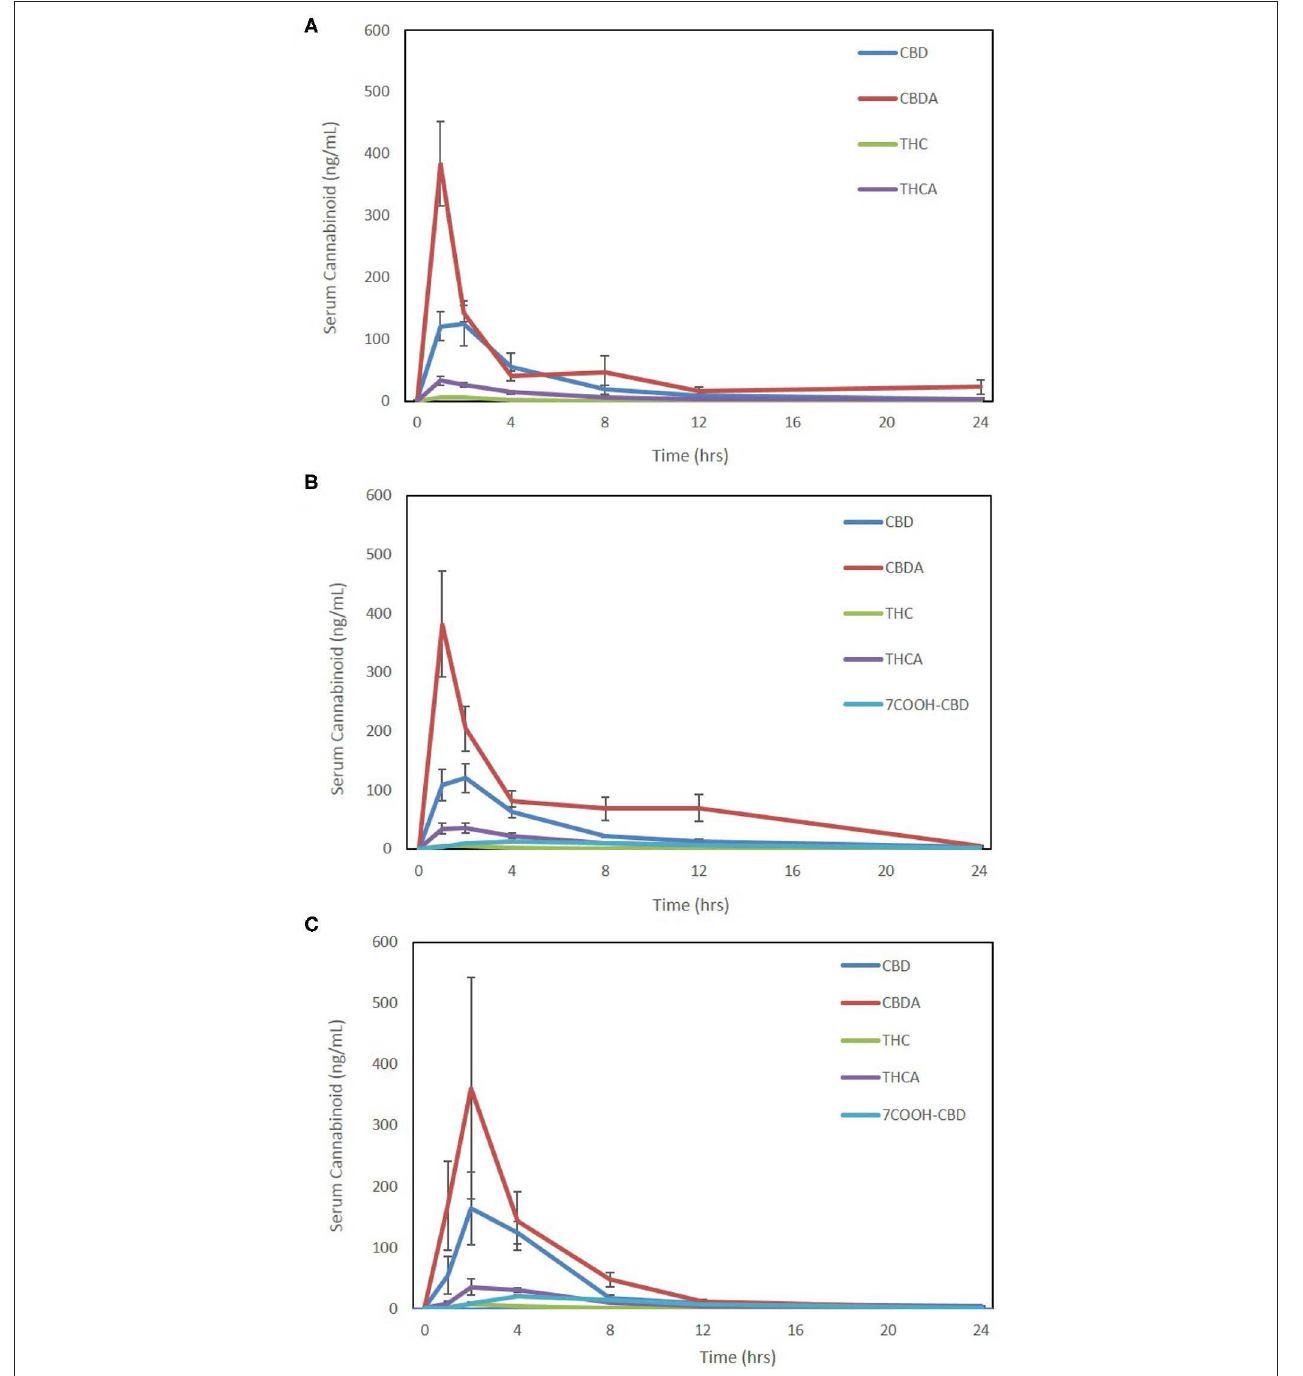
FIGURE 2 | Seven-point 24-h pharmacokinetics of three oral hemp-based forms showing oral absorption kinetics (mean and SEM) of cannabidiol (CBD-blue), cannabidiolic acid (CBDA-red), 1 9-tetrahydrocannabinol (THC-green), tetrahydrocannabinolic acid (THCA-purple), and 7-carboxy- cannabidiol (7-COOH-CBD- light blue for Form 2 and Form 3 only). (A) Oral absorption using 25% MCT/75% sesame oil base at 2 mg/kg dosing using a 50 mg/mL hemp cannabinoid preparation (Form A); (B) oral absorption using 25% sunflower lecithin/75% sesame oil base at 2 mg/kg dosing using a 50 mg/mL hemp cannabinoid preparation (Form 2); and (C) oral absorption using a 10mg hemp cannabinoid/10g chew (Form 3) at ∼ 2–2.3 mg/kg body weight. laboratory and animal care personnel showed no abnormalities biliary stasis as measured by total bilirubin shows no significant in behavior or health problems associated with hemp rises or decreases over the 2-week time period regardless of extract treatment group ( Table 2 ). Daily assessment of the dogs by the